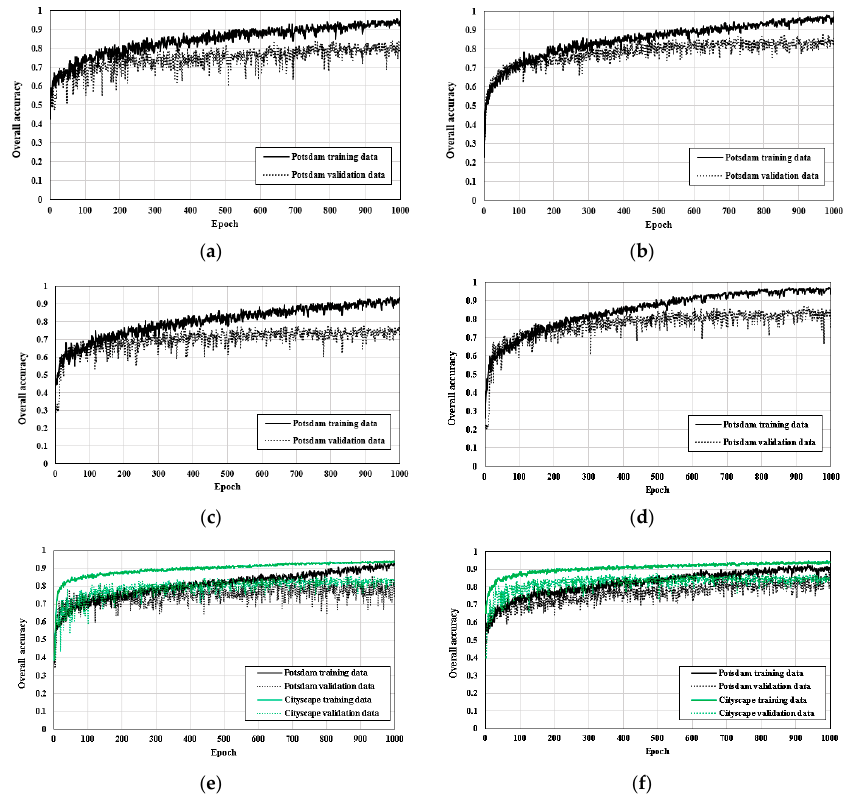
Figure 6. Learning graph of the overall accuracy (OA) for each epoch. ( a ) SegNet with original bands of Potsdam dataset, ( b ) DeepLab-V3+ with original bands of Potsdam dataset, ( c ) simplified U-net with RGB bands of Potsdam dataset, ( d ) simplified U-net with original bands of Potsdam dataset, ( e ) Case 1 wherein training proceeded using both the Potsdam and Cityscape datasets (same sizes) by the combined U-net method. ( f ) Case 2 wherein training proceeded using the Potsdam and Cityscape datasets by the combined U-net method; however, the Cityscape dataset was about twice as large as the Potsdam dataset.